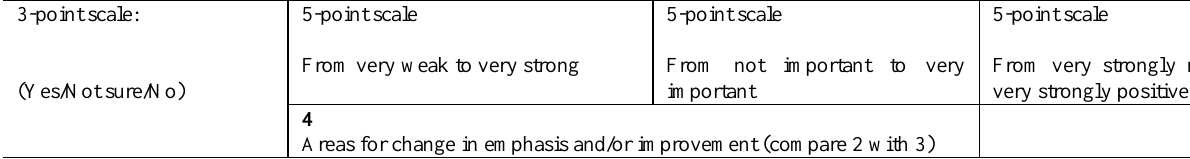
Figure 1: Conceptual research framework: version